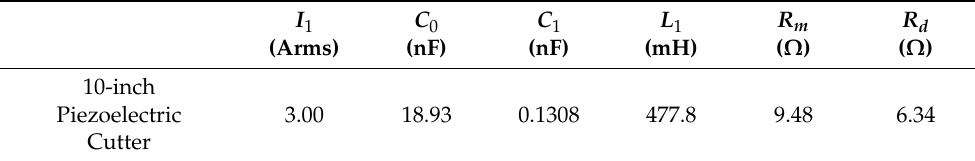
Table 1. Parameters in the proposed model of the high-power piezoelectric